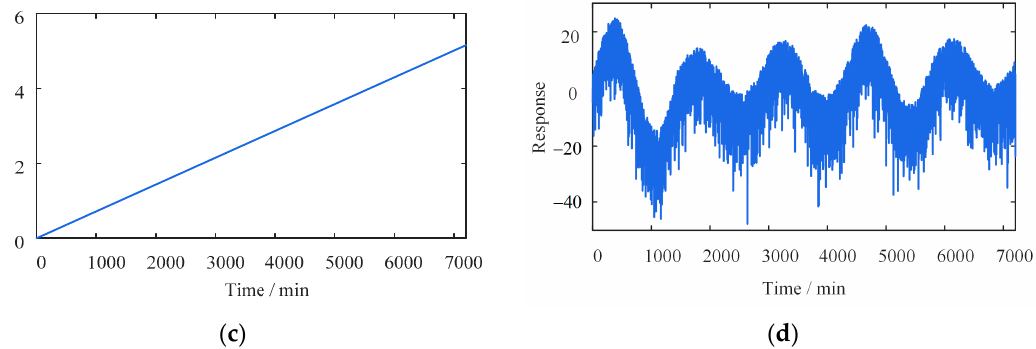
Figure 6. Different types of simulated signals (five days). ( a ) Daily temperature-induced response;